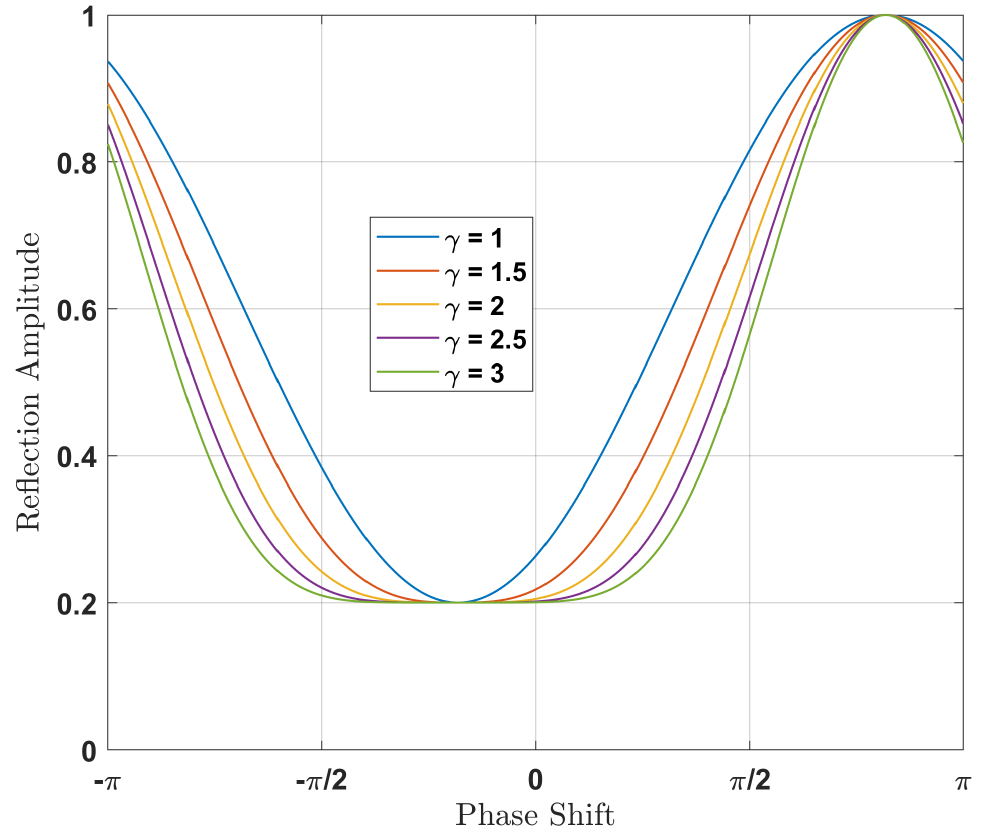
Figure 3. The phase shift model and its different